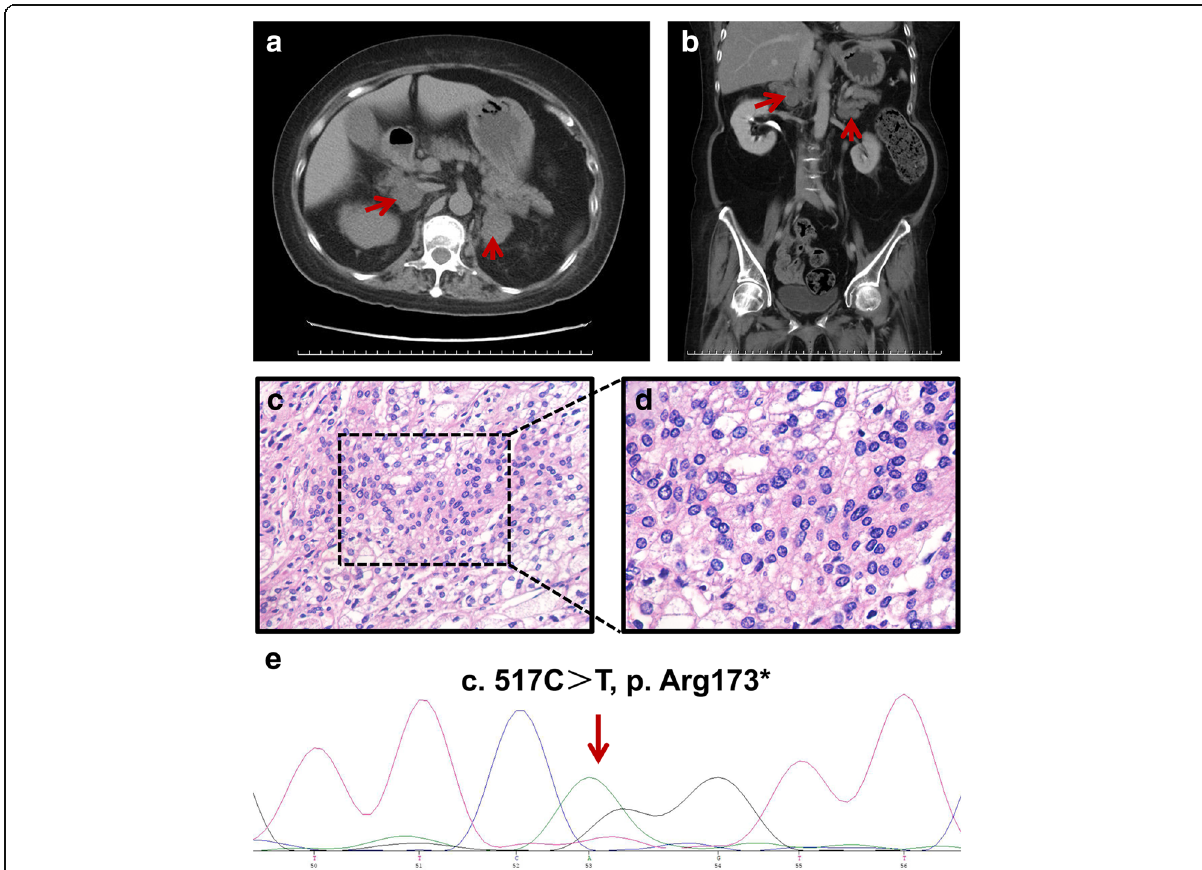
Fig. 1 Results of imaging, histopathology, and DNA sequencing. a and b Adrenal computed tomography scan revealed bilateral adrenal masses (indicated by red arrows). c and d Hematoxylin and eosin staining of the adrenal tissue revealed nodular hyperplasia. e . Sequencing of DNA extracted from peripheral leukocytes identified a novel heterozygous germline ARMC5 mutation, c. 517C > T, p. Arg173*. (indicated by red